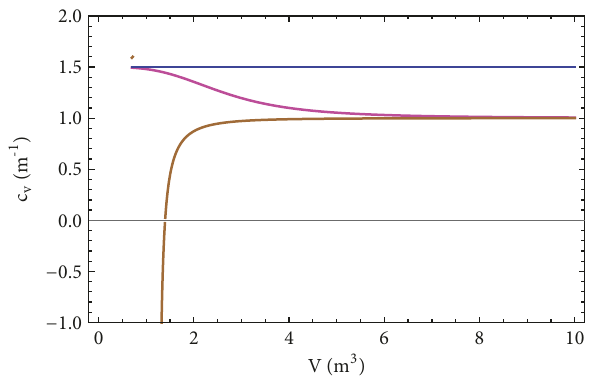
Figure 6: Plots of 𝑐 𝑉 versus 𝑉 for 𝛾 = −2,𝐴 = 2,𝛼 = 0.1,𝜏 = 2.73, 𝑆 = 1, ] = 1, 𝑑 = 1 with 𝑍 = −0.5 (magenta), 0 (blue), and 6